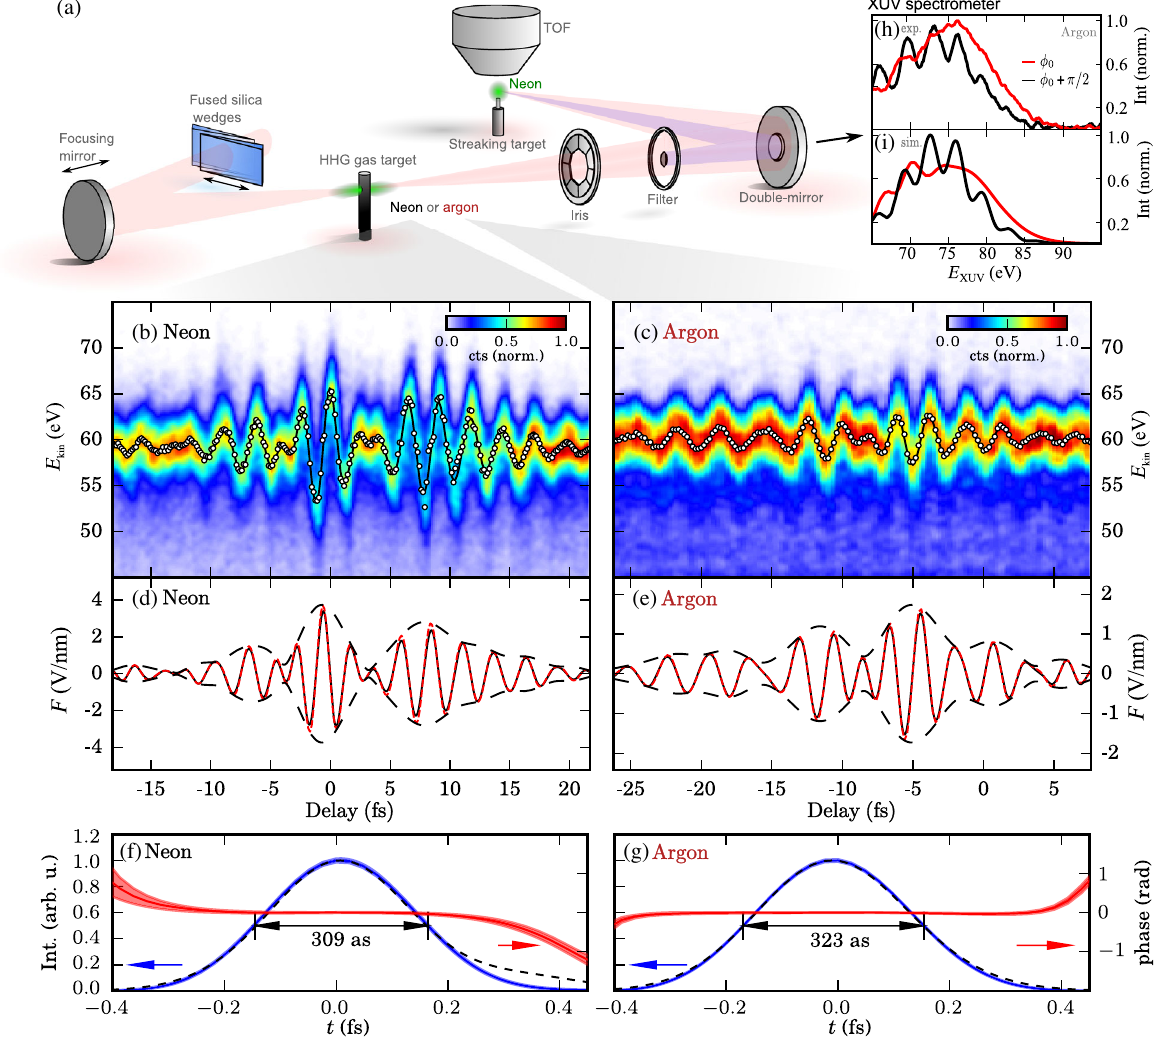
FIG. 1. HHG generation at 80 eV with sub-two-cycle pulses at 750 nm in neon and argon. (a) Scheme of the experimental setup. (b, c) Experimental attosecond streaking traces for isolated attosecond pulse generation through HHG in neon and in argon, respectively. The retrieved raw (dots) and filtered (solid line) streaking curves from the Gaussian fits are shown. (d,e) Electric field reconstructed from the streaking curves from the Gaussian fit (red dashed line) and the ptychographic reconstruction algorithm (black solid line). (f, g) Reconstructed temporal profiles of XUV intensity (blue) and phase (red), for neon and argon, respectively. The black dashed line shows the pulses from the simulation. The shaded areas show the standard deviation (see text for details). (h,i) Experimental and simulated XUV spectra in argon when the double mirror is replaced with a grating spectrometer for two different values of the CEP (see Sec. IV for